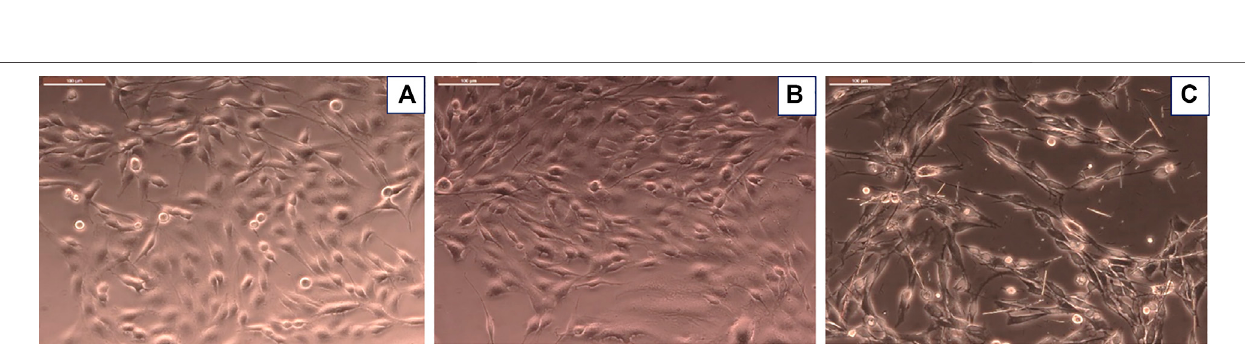
FIGURE5| Glioma cellstreatedwithin fl ammatorystimulusinpresenceof20 μ g/mlofCuHARScausessigni fi canttoxicitytothecells. (A) Controlcellstreatedwith media alone. (B) Cells treated with in fl ammatory agents. (C) Cells treated with in fl ammatory agents and 20 μ g/ml of CuHARS, Scale bar (cid:2) 100 µm (upper left of each fi gure); Magni fi cation (cid:2) ×